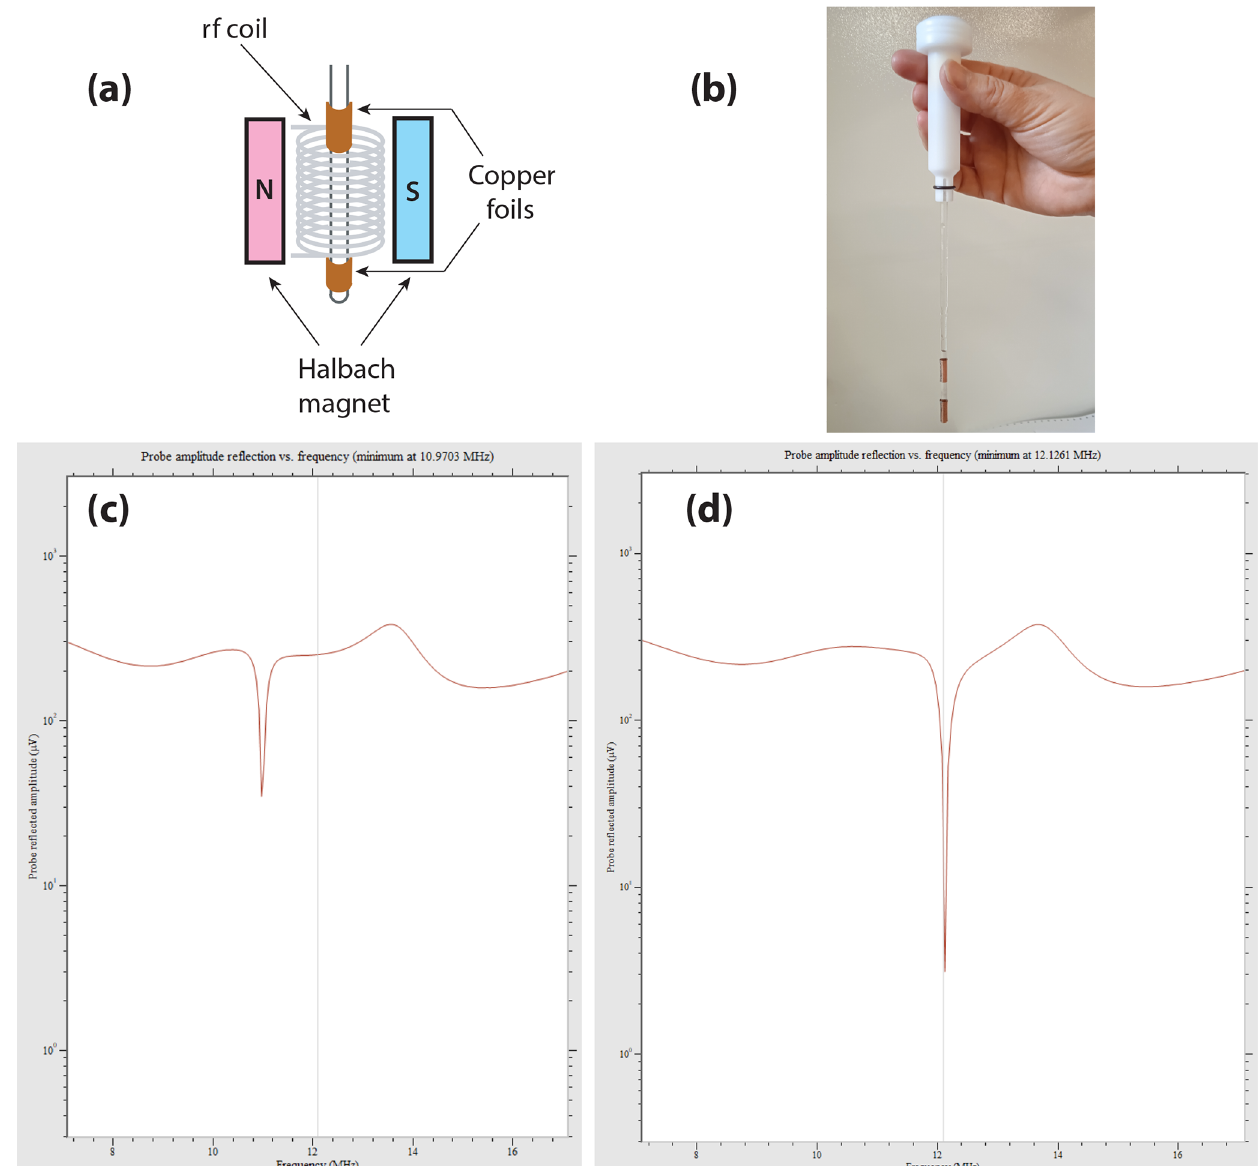
Figure 10. Example of the effect observed on the wobble curve of the X channel on the Magritek Spinsolve Carbon 43 when simple copper foils are wrapped around the NMR tube. (a) Scheme of the setup, with the copper foils wrapped around the NMR tube; (b) picture of one of these tubes. As we were limited to an outer diameter of 5mm, the lower part of the NMR tube receiving the foils was only 4mm; (c) wobble curve of the X channel without the copper foils; (d) wobble curve with the copper coils.